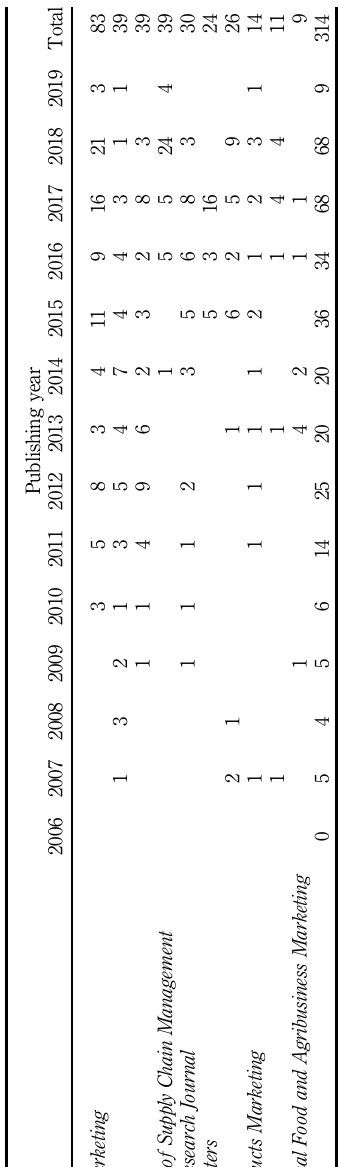
Table II. Top journals contributing to the area of